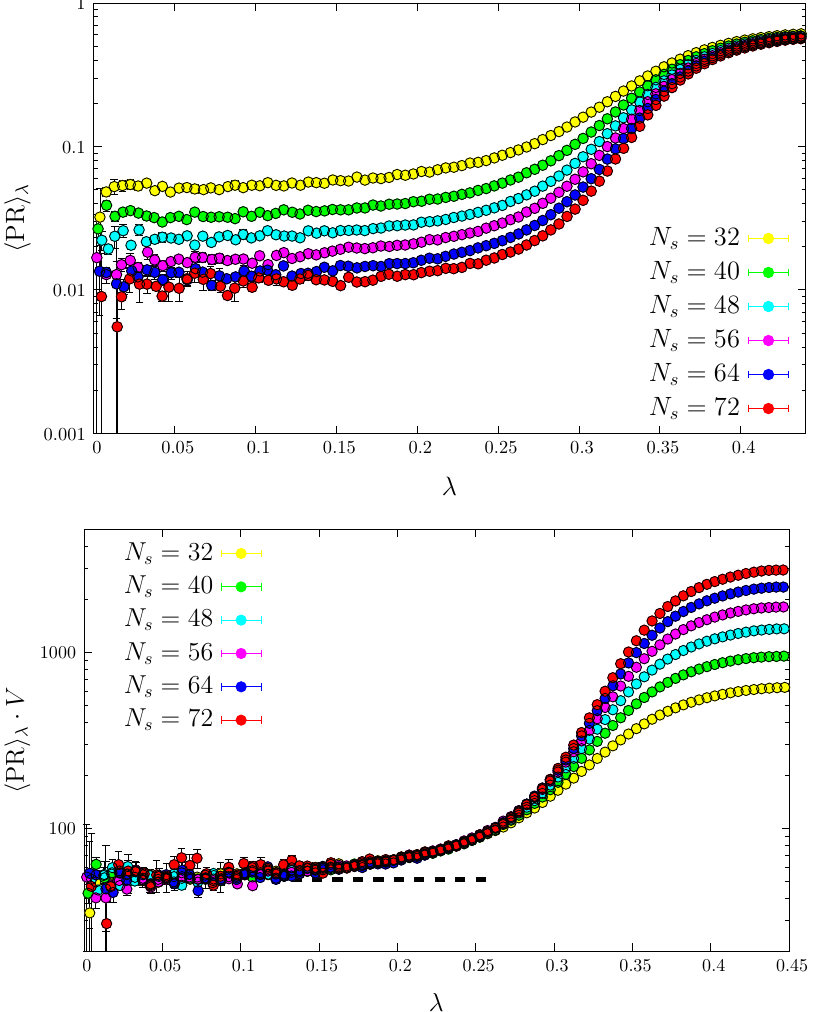
Figure 1 . Participation ratio ¯ β = 5 . 50 as a function of the spectral region for various volumes (in logarithmic scale). The dashed line in the bottom panel is the PR of the lowest mode extrapolated to infinite lattice size (see